Question: What form of chart is displayed?
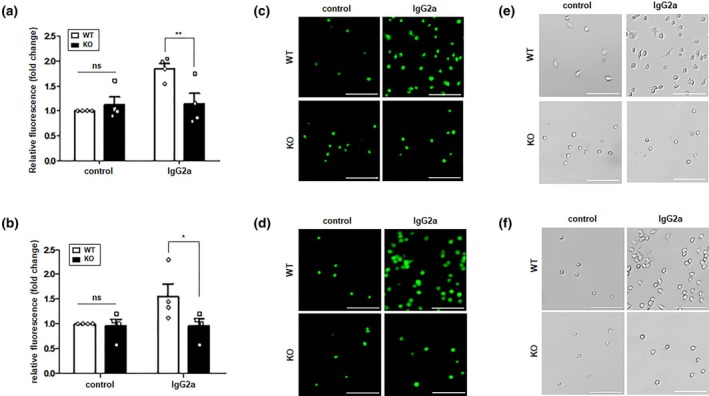
Answer: bar